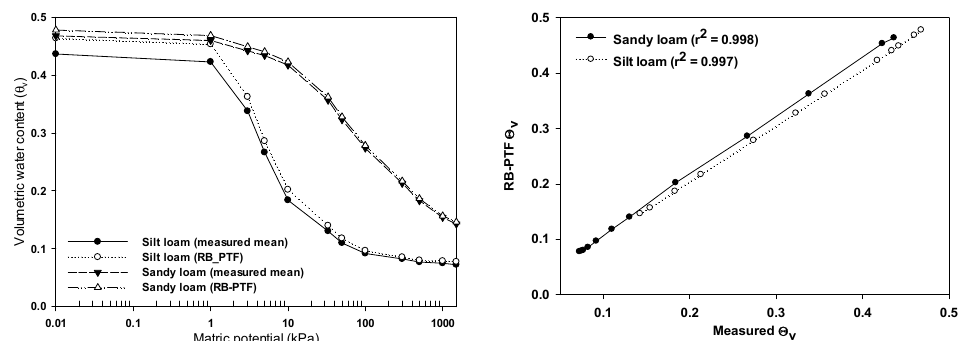
Figure 5. Estimated and mean measured SWRCs of sandy loam and silt loam soil and comparison of volumetric water content between the estimated and the measured mean for both soil textures for Ap horizon soils of five soil series.